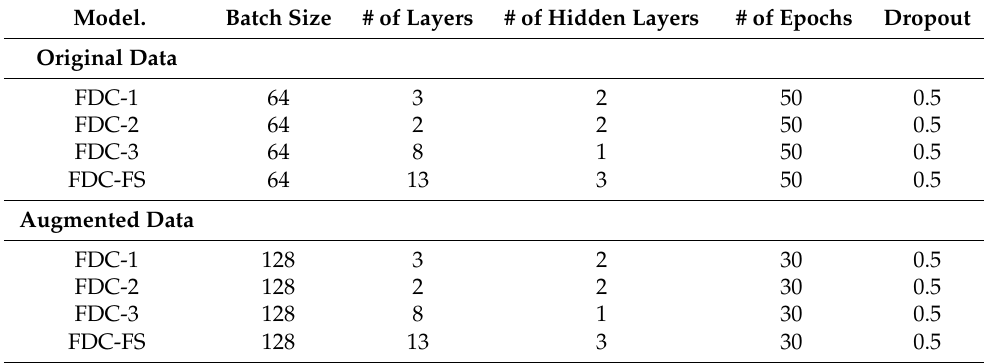
Table 1. FDC Model